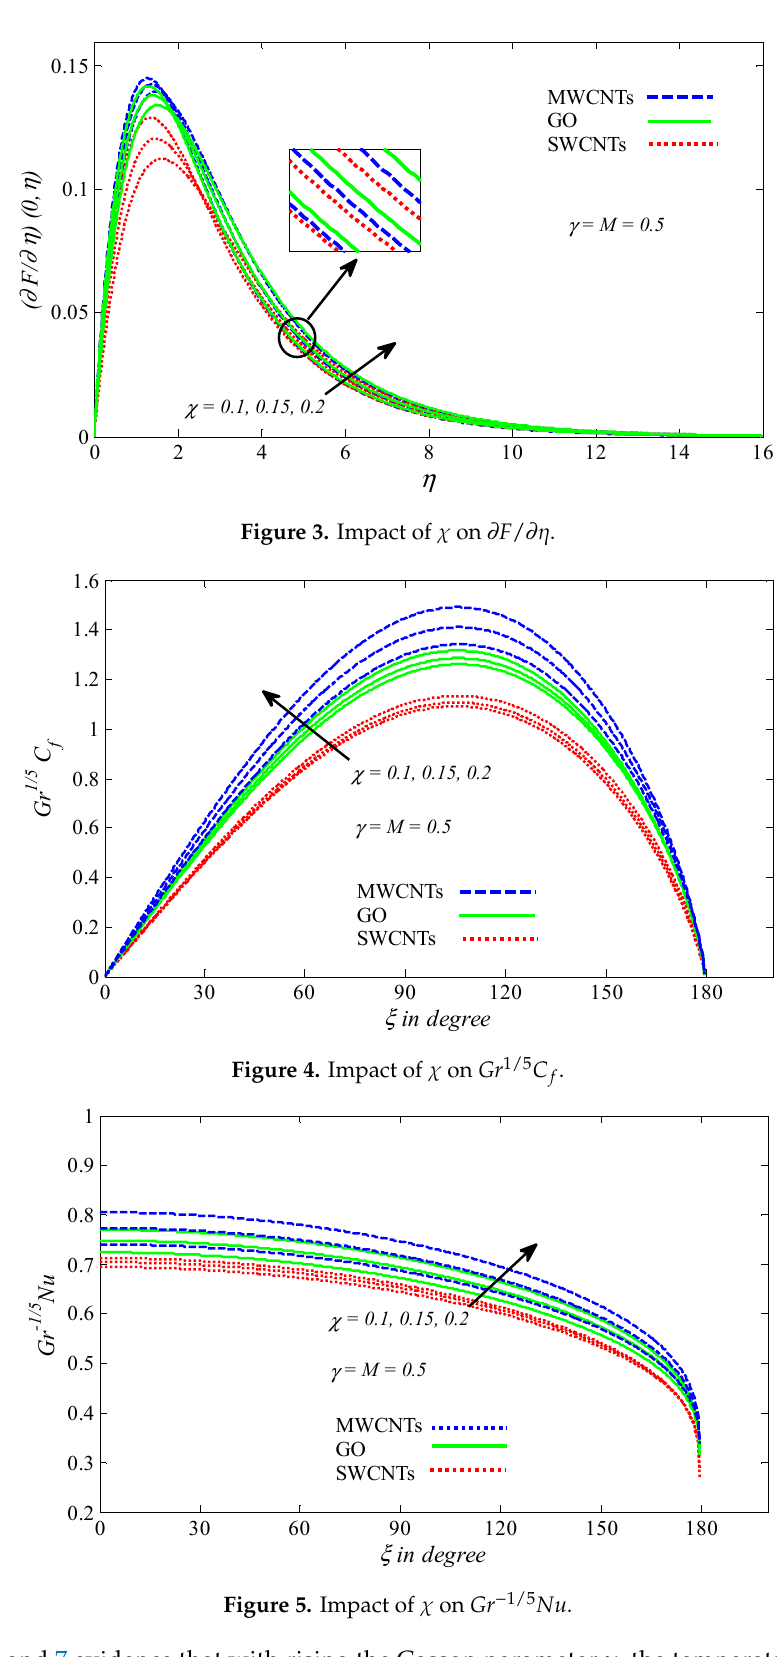
Figure 5. Impact of χ on Gr − 1/5 Nu